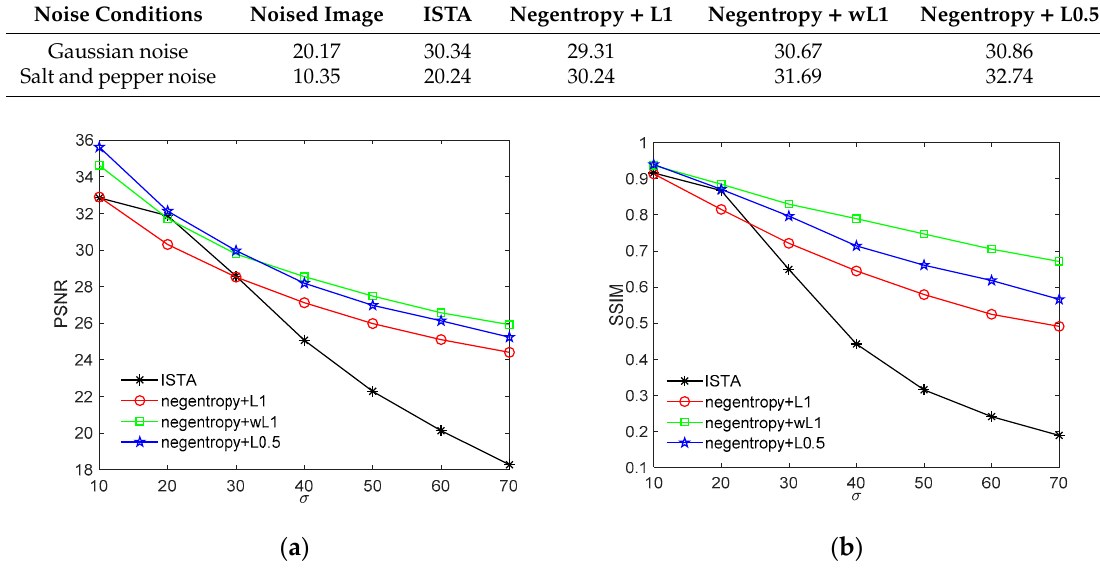
Figure 8. Comparison between ISTA and the proposed algorithm for recovering image with Gaussian noise with standard deviation ranging from 10 to 70. ( a ) PSNR value of recovered image versus noise intensity; ( b ) structural similarity (SSIM) value of recovered image versus noise intensity.